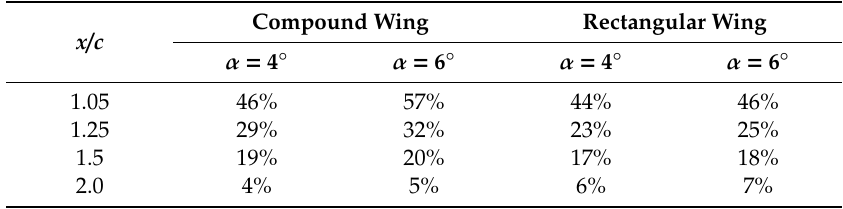
Table 3. Maximum velocity deficiency in the wake area in the back of the compound and the rectangular